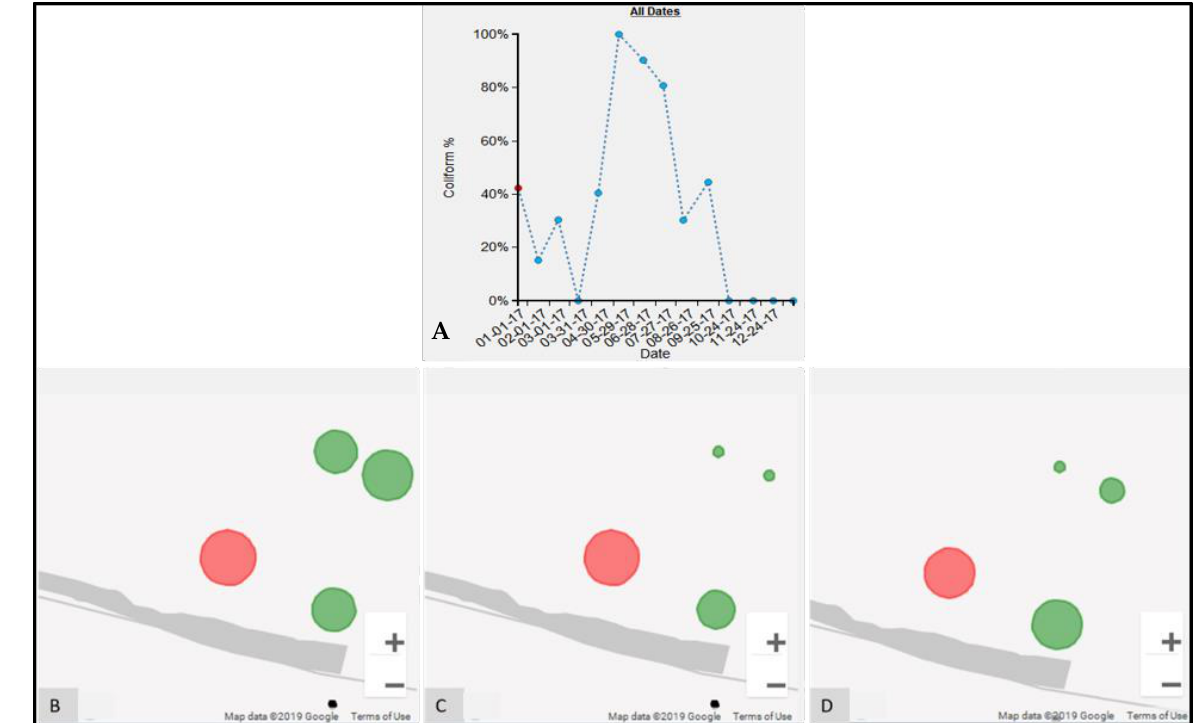
Figure 14. FC count data for water point S17 in S neighborhood. ( A ) Time-chart for S17 water point, the red ellipse indicates periods of high FC count; ( B ) proportional symbol map for FC count for May; ( C ) proportional symbol map for FC count for June; ( D ) proportional symbol map for FC count for July.